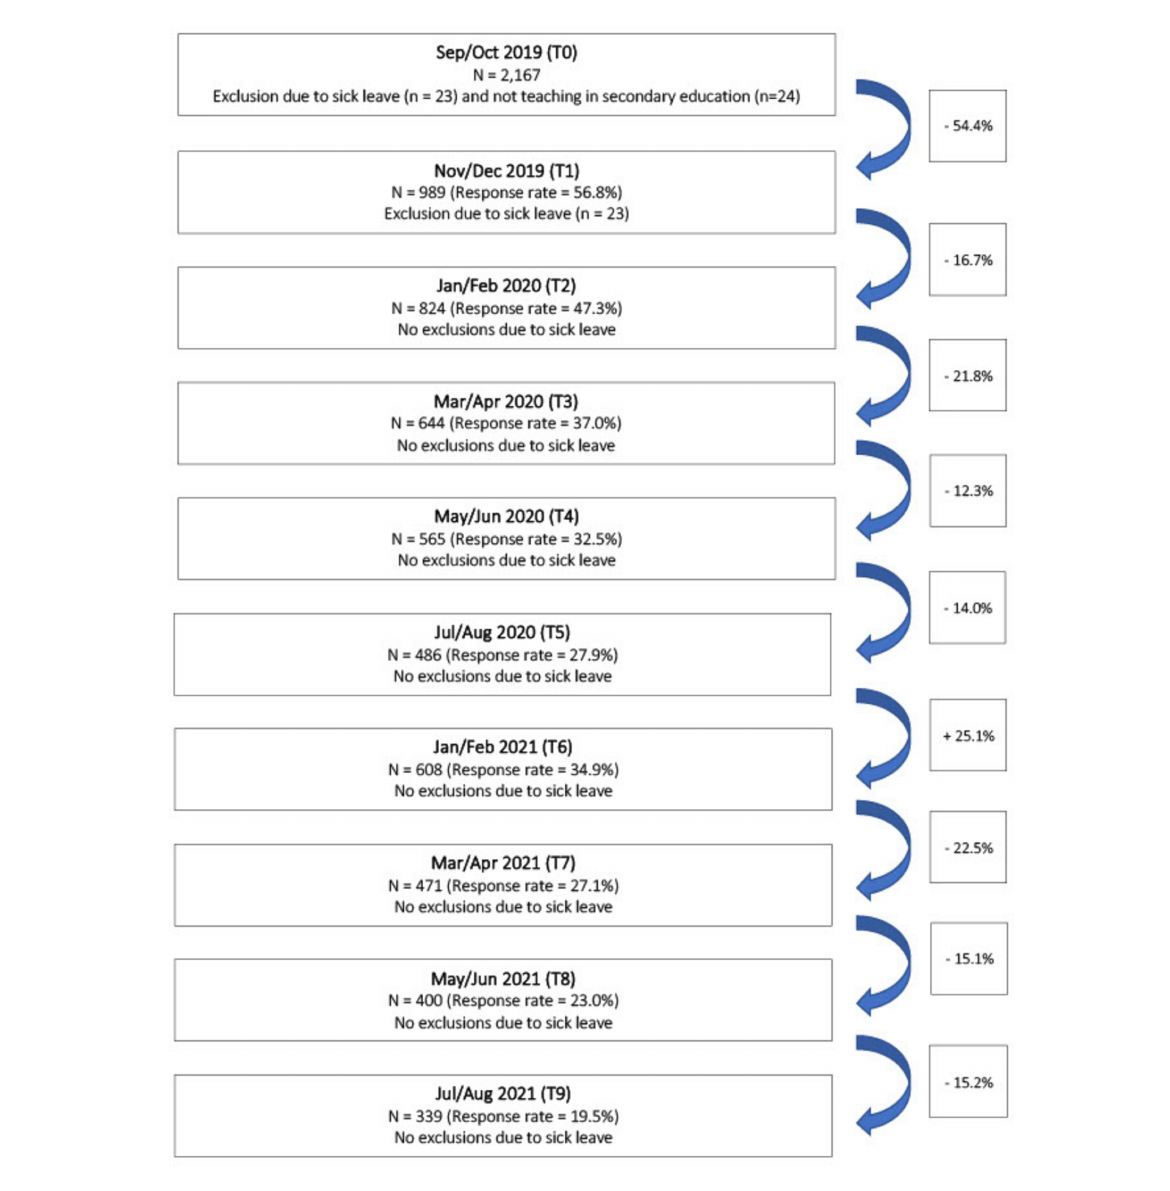
FIGURE2 Flow chart with drop-out rates across all time